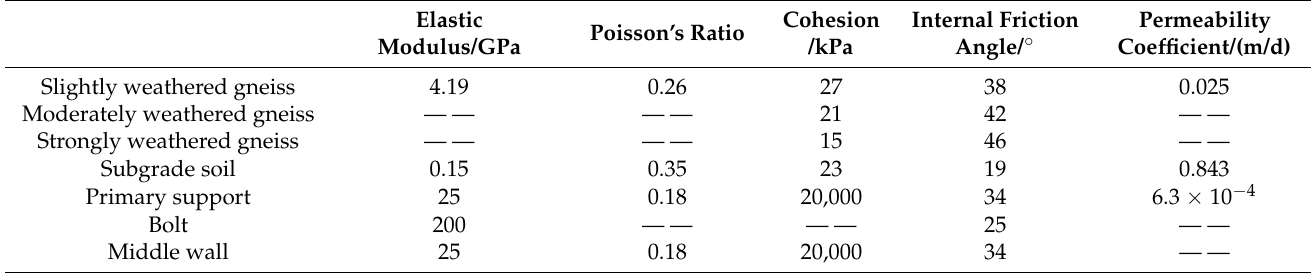
Table 1. The parameters of calculation.